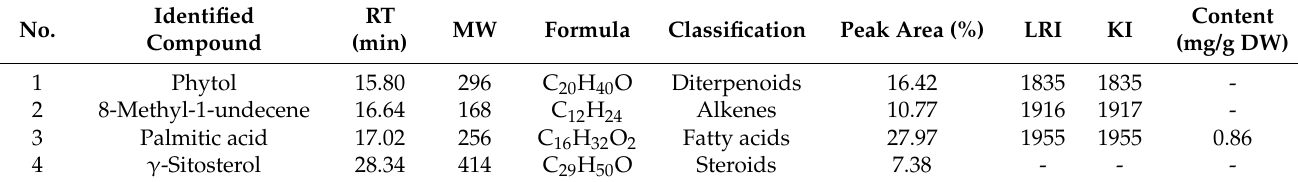
Table 5. Dominant phytochemicals in H-Anvi extract from A. vigirnicus identified by GC-MS.